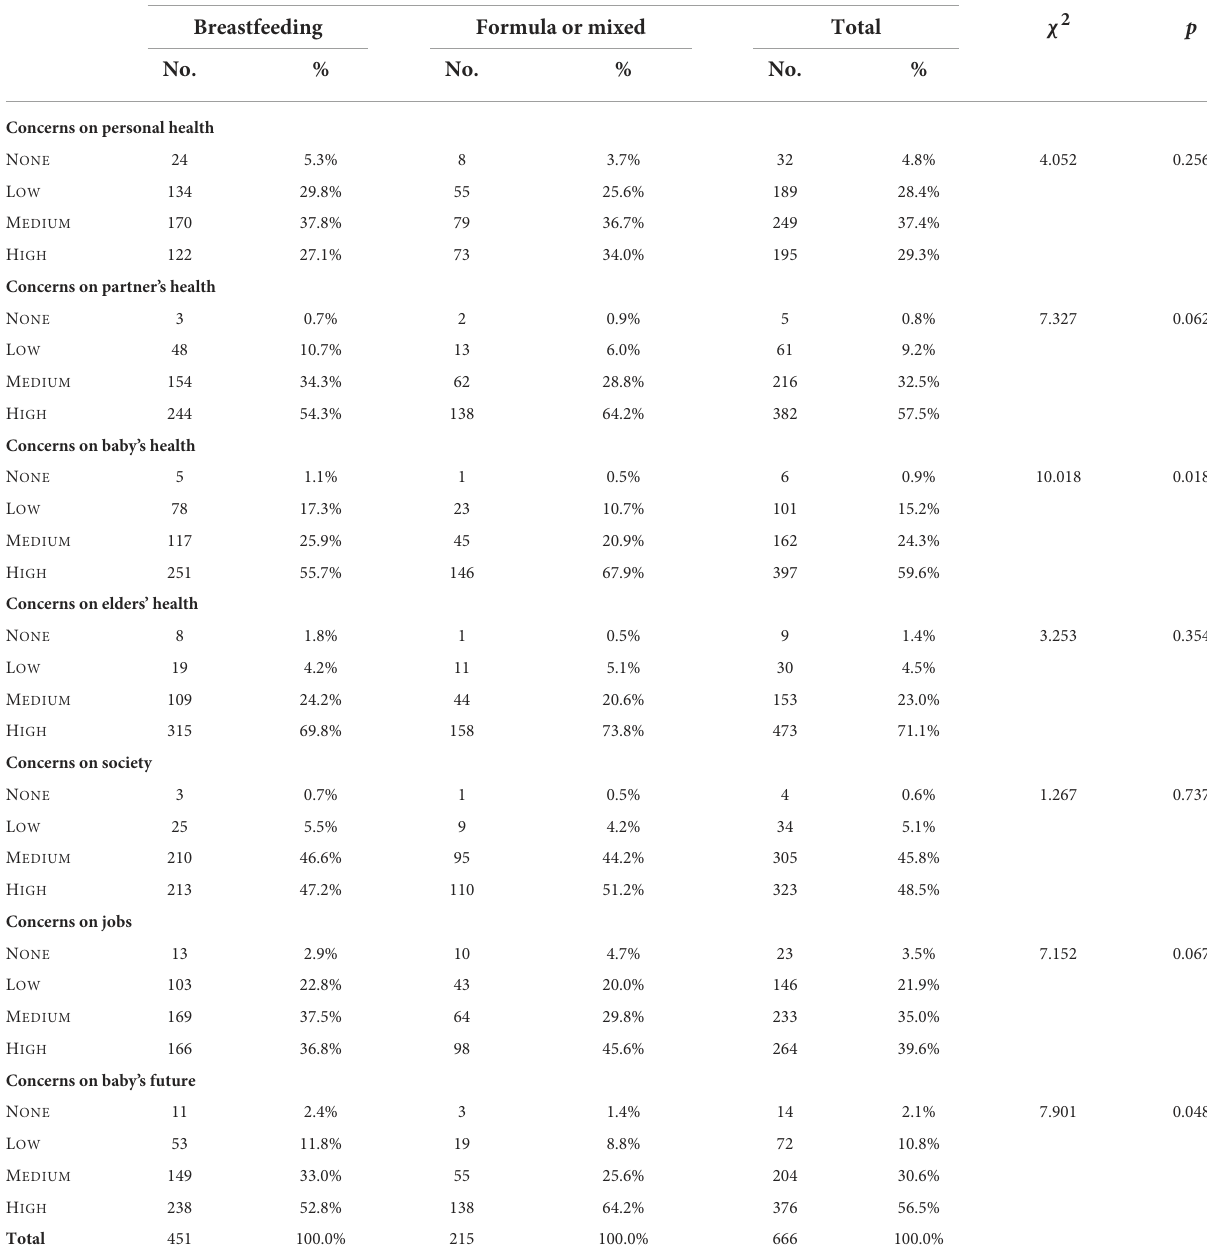
TABLE 2 Concerns on health and social issues according to feeding practices. Feeding pattern Breastfeeding Formula or mixed